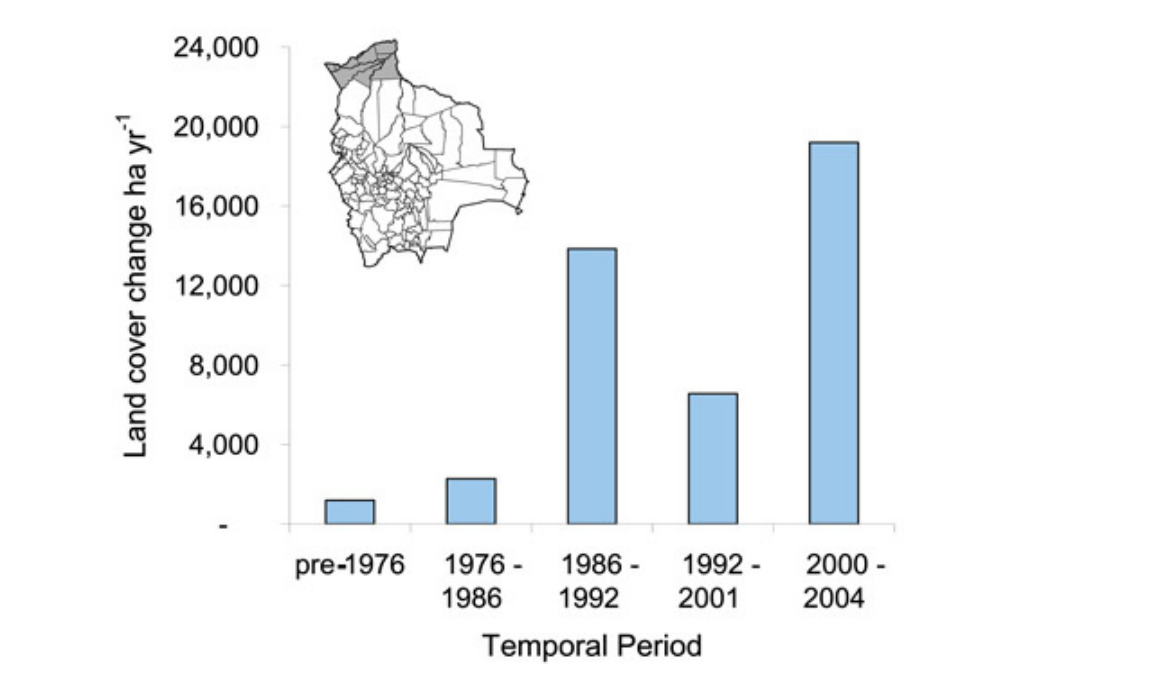
Fig. 6. Deforestation rates for 15 municipalities in northern Bolivia (see inset). The peak in deforestation between 1986 and 1992 occurred after Brazil ended subsidies to rubber collectors. The value for the most recent period is an underestimate because of incomplete coverage for this period (modified from Killeen et al.